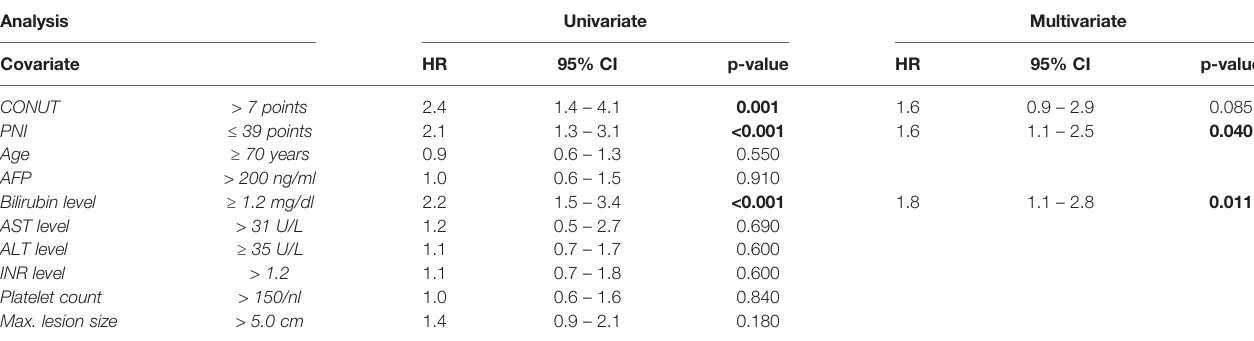
TABLE 3 | Univariate and multivariate Cox proportional hazards regression models evaluating the PNI, CONUT, and other risk factors for the subgroup of recommended TACE candidates (n=126). Analysis Covariate